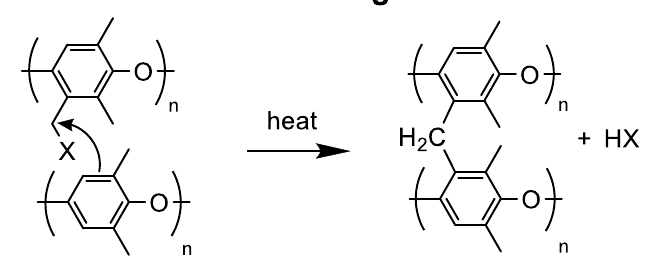
Figure 16. Friedel–Crafts crosslink mechanism.